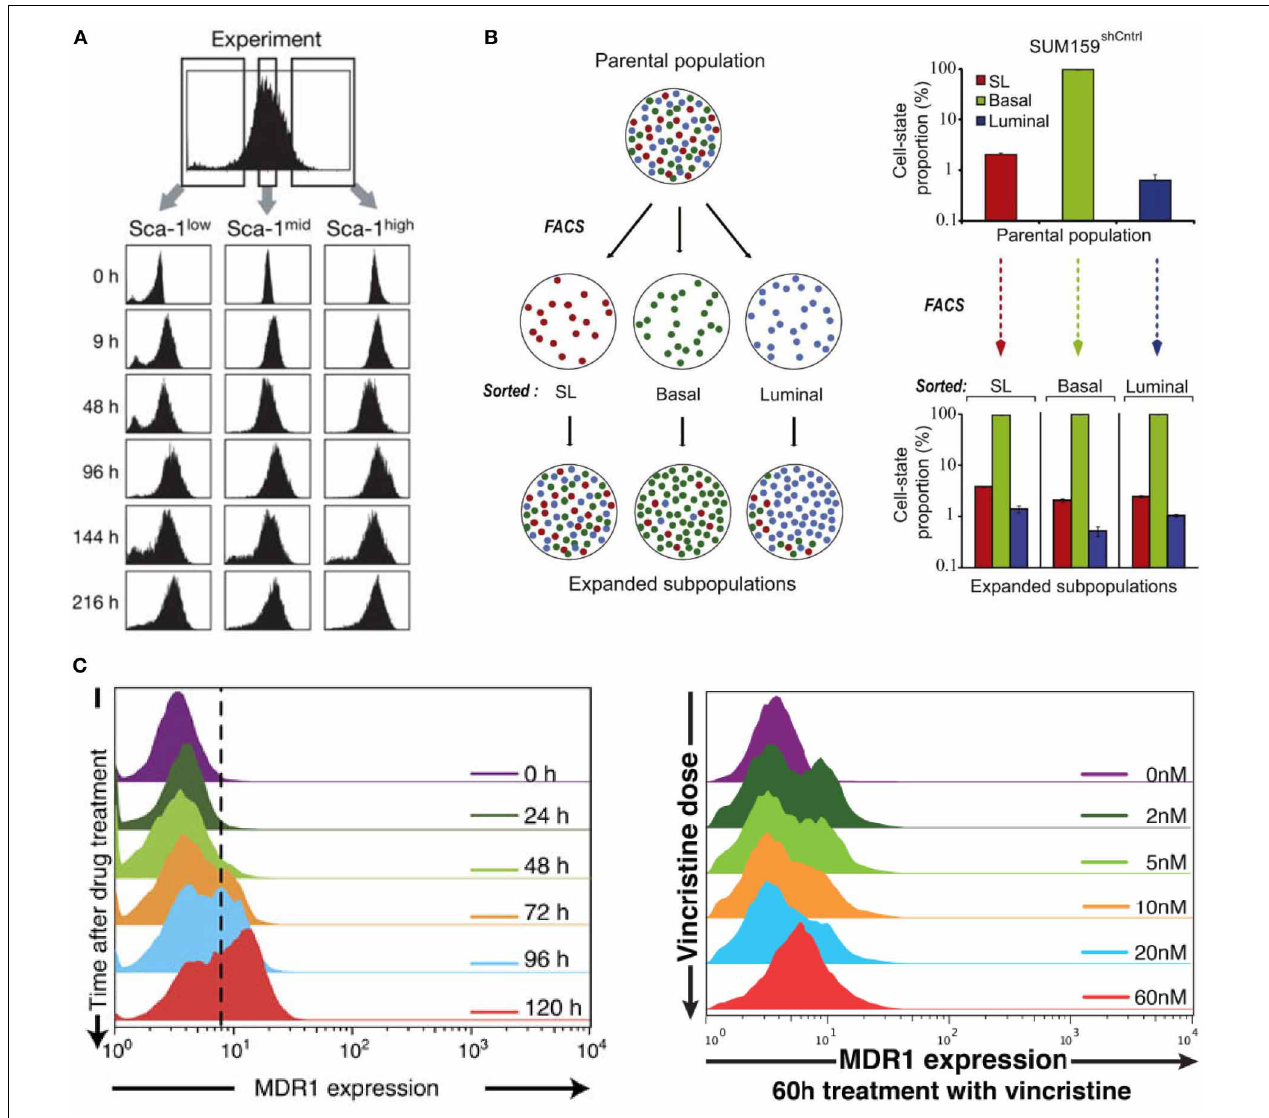
FIGURE 1 | Non-genetic heterogeneity in living cells. Re-culturing cells sorted into (A) low, medium and high expressions of Sca-1 in mouse hematopoietic cells, (B) SL, Basal, and Luminal expressed breast carcinoma cells, returns to original parental metastable or equilibrium